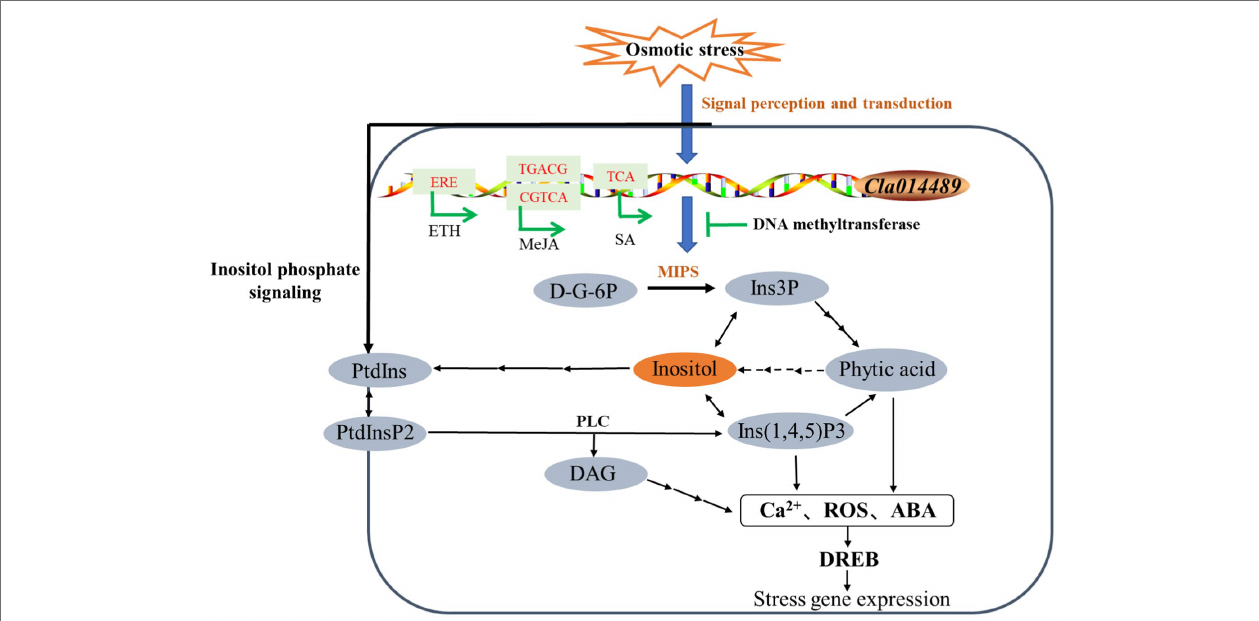
FIGURE 8 | Model of regulation of ClMIPS in response to osmotic stress. “ → ” represents induction of phytohormone, while “ ⊥ ” stands for suppression. Solid lines indicate identified pathways and dashed lines indicate speculative